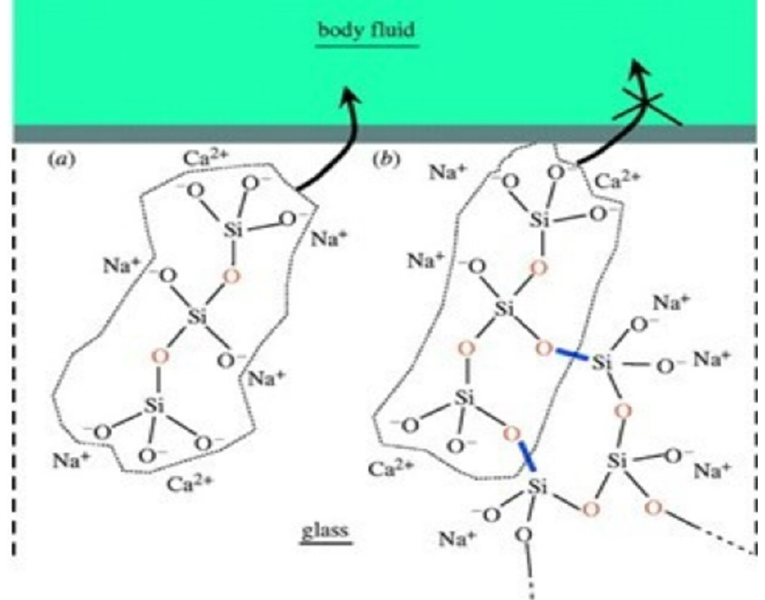
Figure 8. The chemical structure of bioactive glasses; ( a ) showing no linkage with the adjacent structure, where ( b ) showing cross-linked structure, Ca = calcium; Na = sodium; O = oxygen; Si = silicon [110].